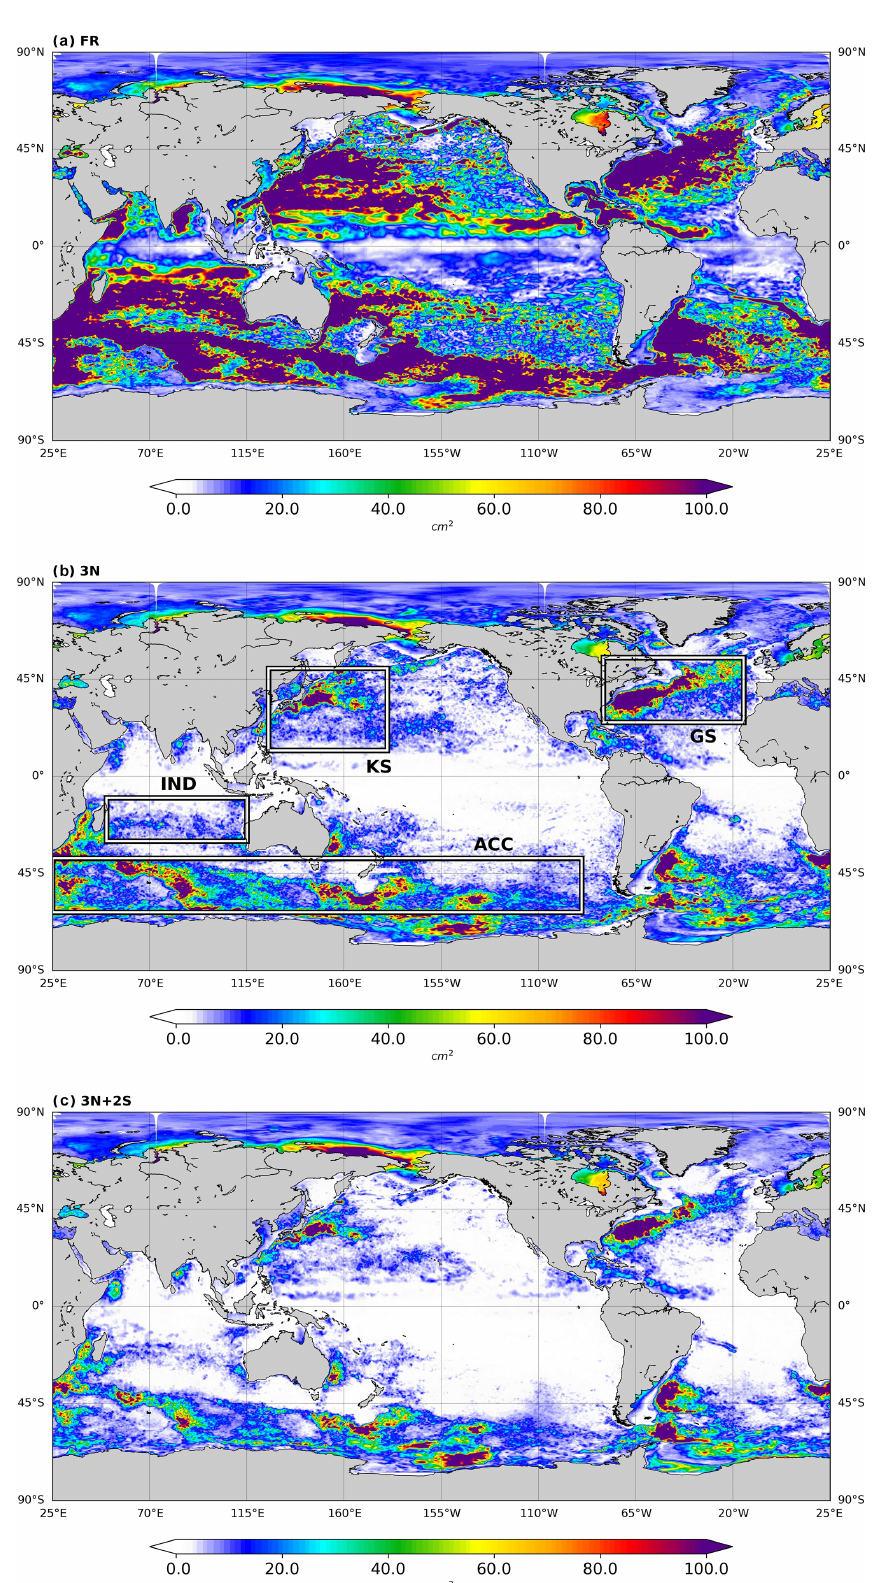
Figure 5. Global maps of SSH analysis error (NR – model analysis) variance (in cm 2 , 2015). (a) Free run (FR); (b) with three nadirs (3N); (c) assimilation of three nadir and two wide-swath instruments (3N + 2S). In panel (b) , GS: Gulf Stream, ACC: the Antarctic Circumpolar Current, KS: Kuroshio Current and IND: South Indian Ocean. Ocean Sci., 18, 609–625, 2022